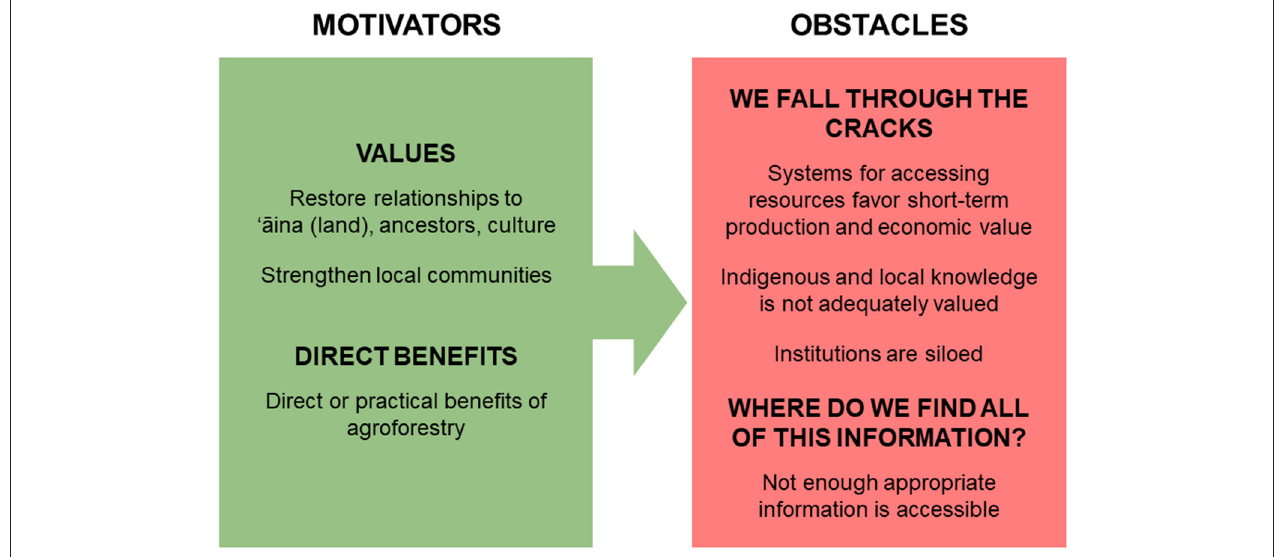
FIGURE 2 | Practitioners in Hawai‘i were motivated to practice agroforestry largely by their values, but also the direct or practical benefits of agroforestry (green box). These motivations, and the resulting diverse agroforestry systems, directly conflict with the dominant values, institutions, and systems of resource access, which produces a suite of agroforestry-specific obstacles (red box). Institutions include local, state, and federal agencies and organizations that support and regulate practitioners as well as social norms and worldviews. For themes and illustrative quotes, see Table 1 (motivators) and Table 2 (agroforestry-specific